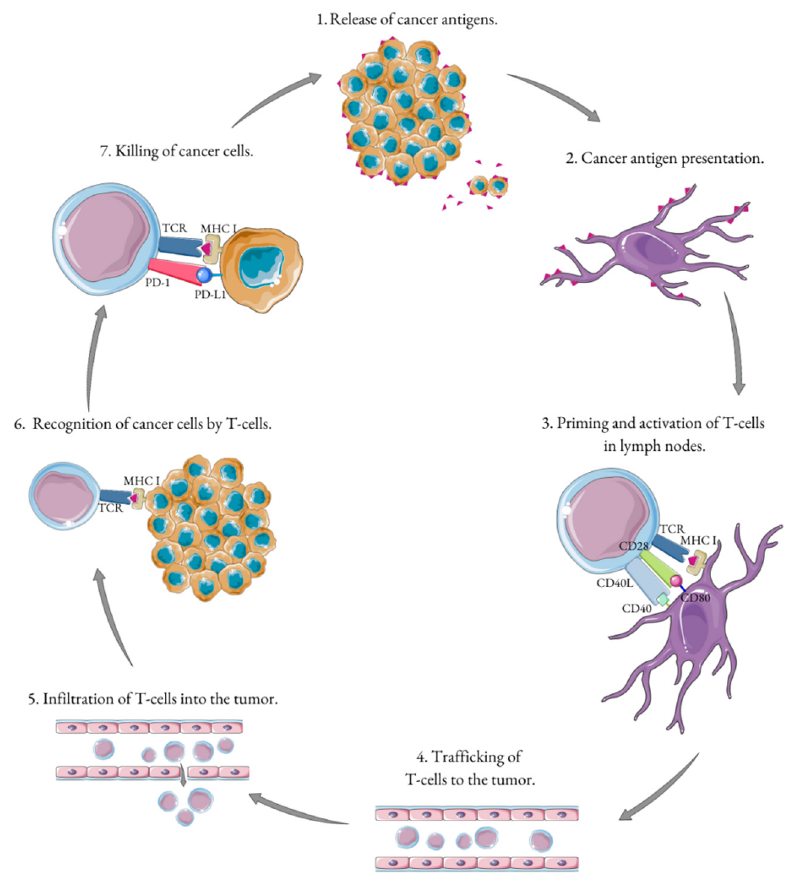
Figure 1. Schematic overview of cancer immunity cycle.